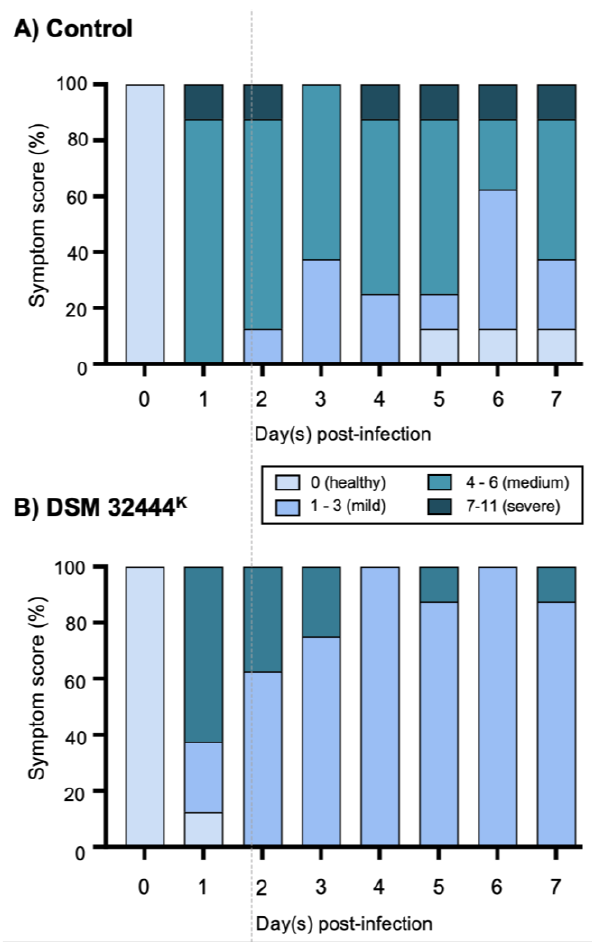
Figure 1. Clinical signs, change in body temperature, and weight loss exhibited by ferrets treated with DSM 32444 K (panel B ) or mock-treated (panel A ) with PBS following infection with H7N9 AIV. Ferrets were treated with 0.5 mL of DSM 32444 K or PBS on four separate occasions, 7 days apart, followed by infection with H7N9 AIV 7 days after the last treatment. Individual values were plotted per animal, and lines indicate the mean values per group. All ferrets were scored for clinical signs daily following infection according to the clinical score system presented in Supplementary Table S1. The cumulative daily clinical scores were represented